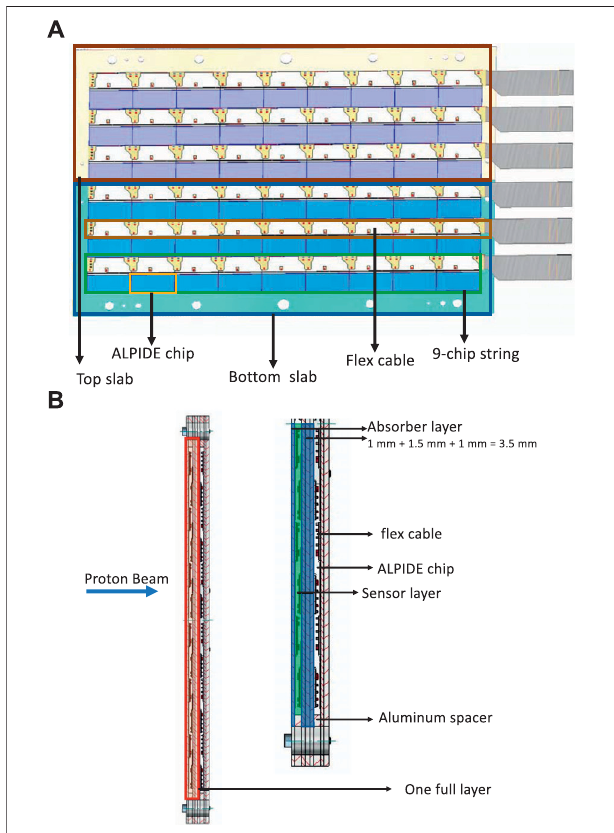
FIGURE4| Cooling conceptofthecalorimeter layers:twoaluminumcoldplates,each ofdimension 20 mm × 290 mm × 280 mm, willbeplacedabove and below the calorimeter layers as a part of a closed loop liquid-cooling system.